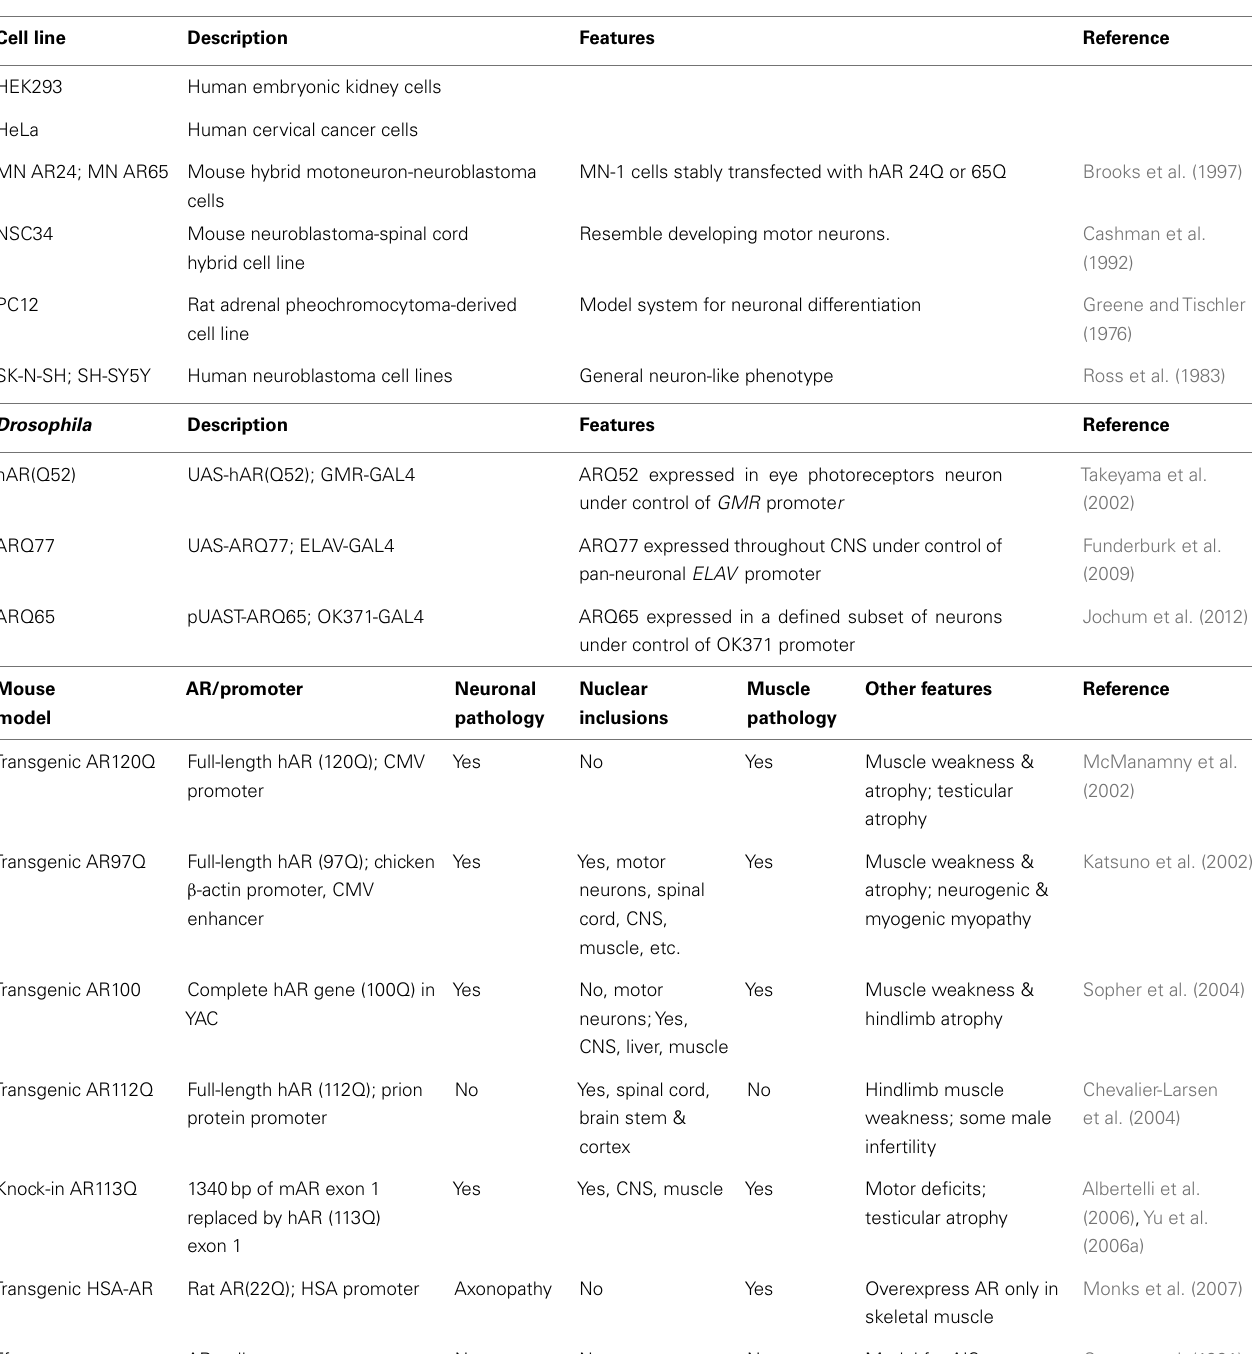
Table 1 | Cell and animal models of